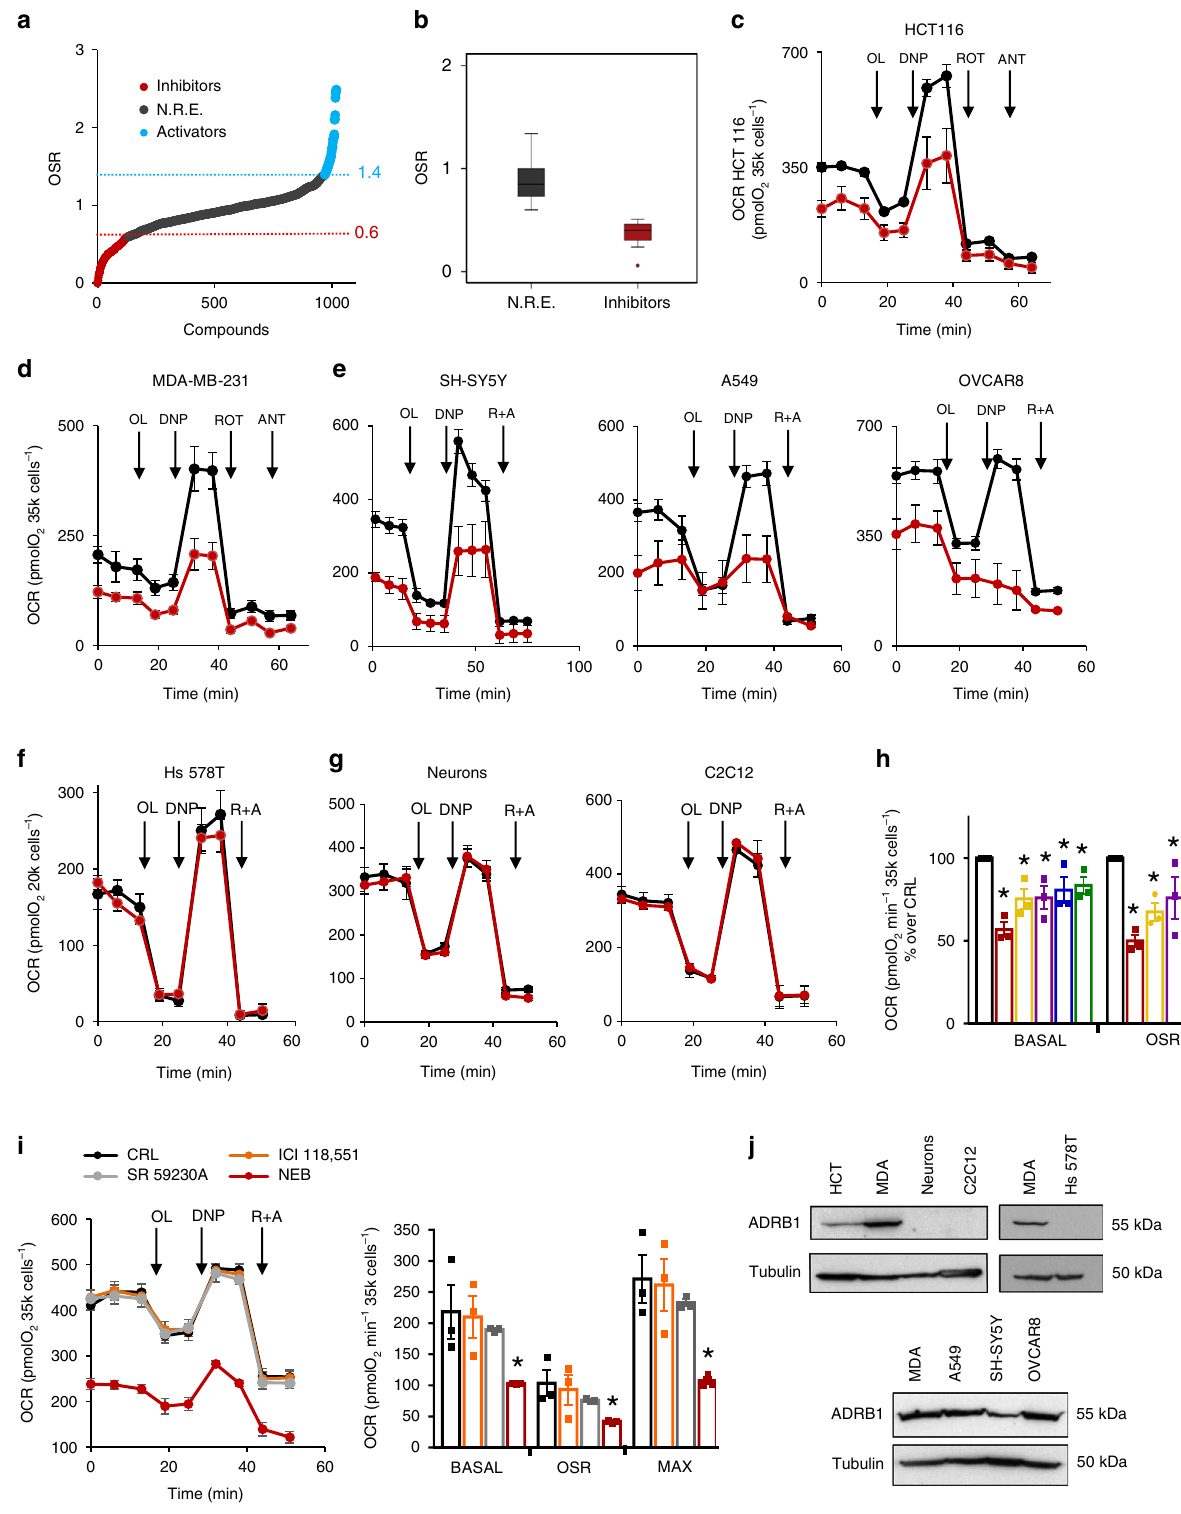
to a different organization of OXPHOS complexes 25,26 . However, BN-PAGE analysis of the supramolecular organization of OXPHOS complexes after nebivolol treatment of HCT116 cells indicated no relevant changes in their supramolecular organiza- tion (Fig. 3a), supporting that the inhibition of maximum respiration triggered by nebivolol should be ascribed to another mechanism. Interestingly, IF1 was also found bound to the